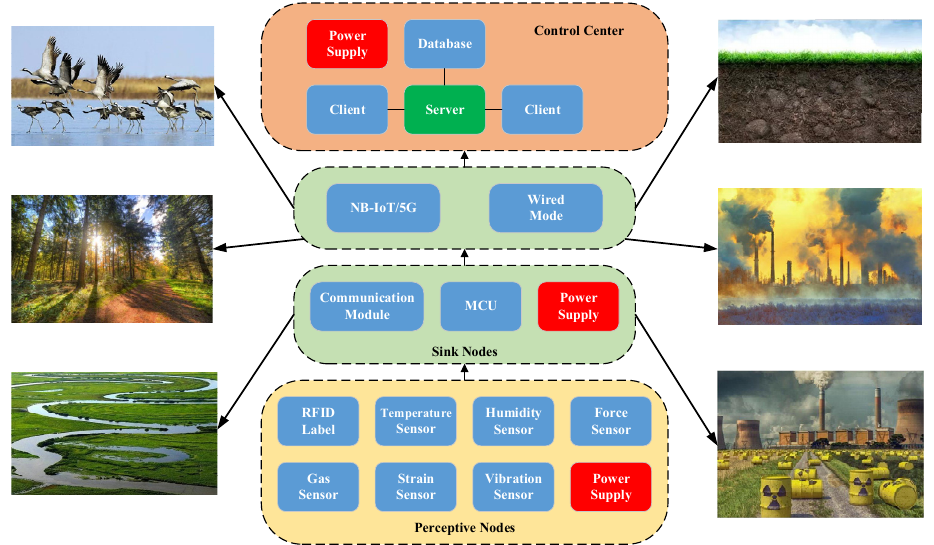
Figure 1. Structure of environmental monitoring based on the Internet of Things